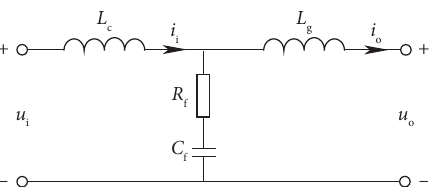
Figure 4: LCL grid-connected flter topology with a damping